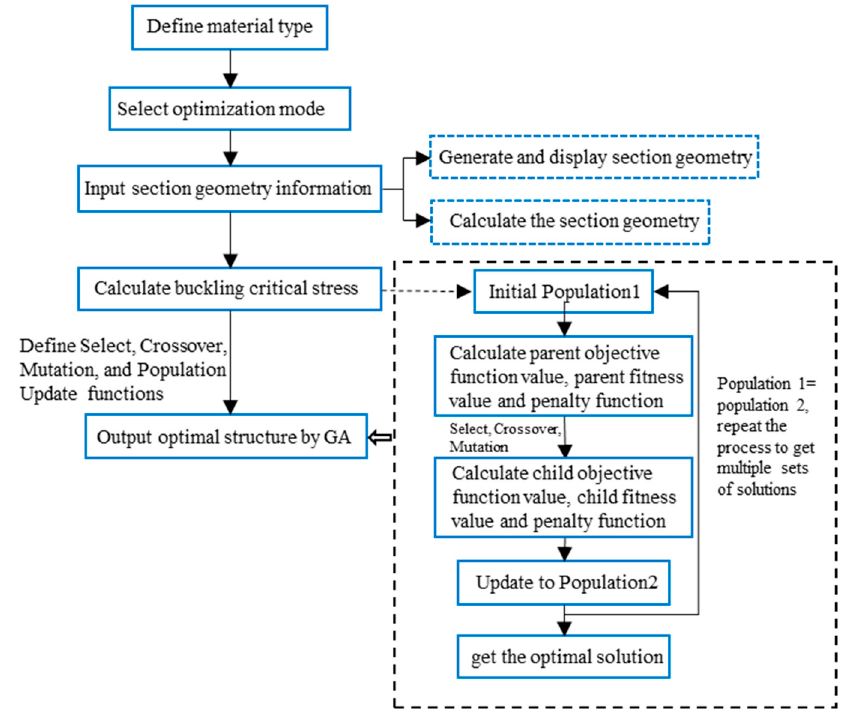
Figure 11. Program flowchart.